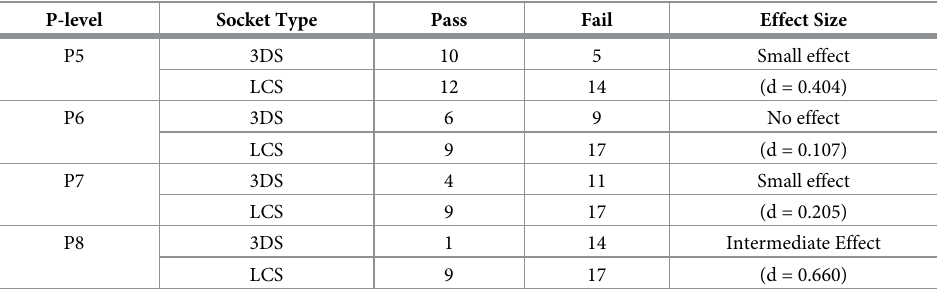
Table 4. The proportion of failure rate for 3DS and